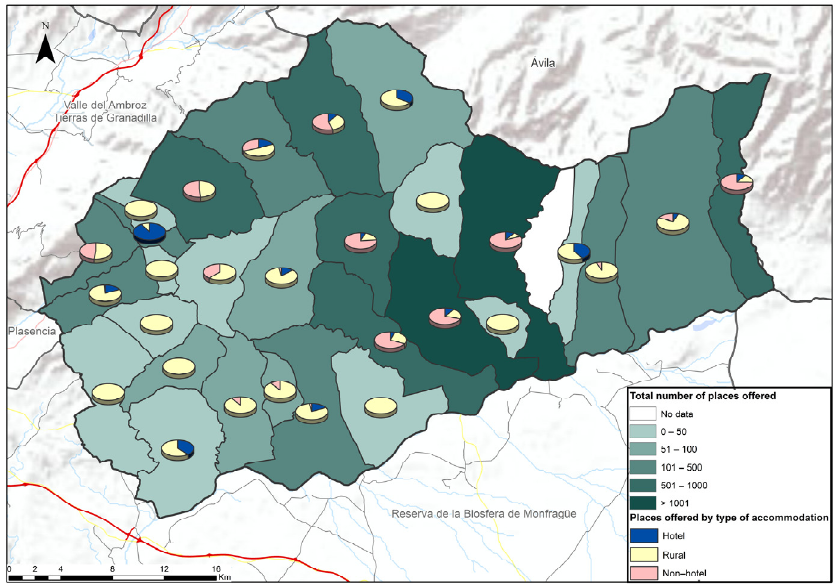
Figure 11. Map of the number of vacancies offered and their typologies by municipality.